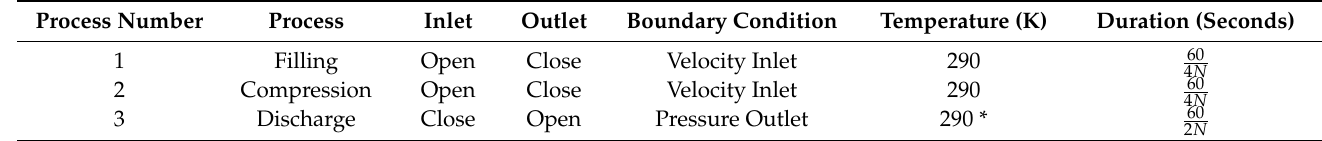
Table 1. Boundary Conditions of the compression